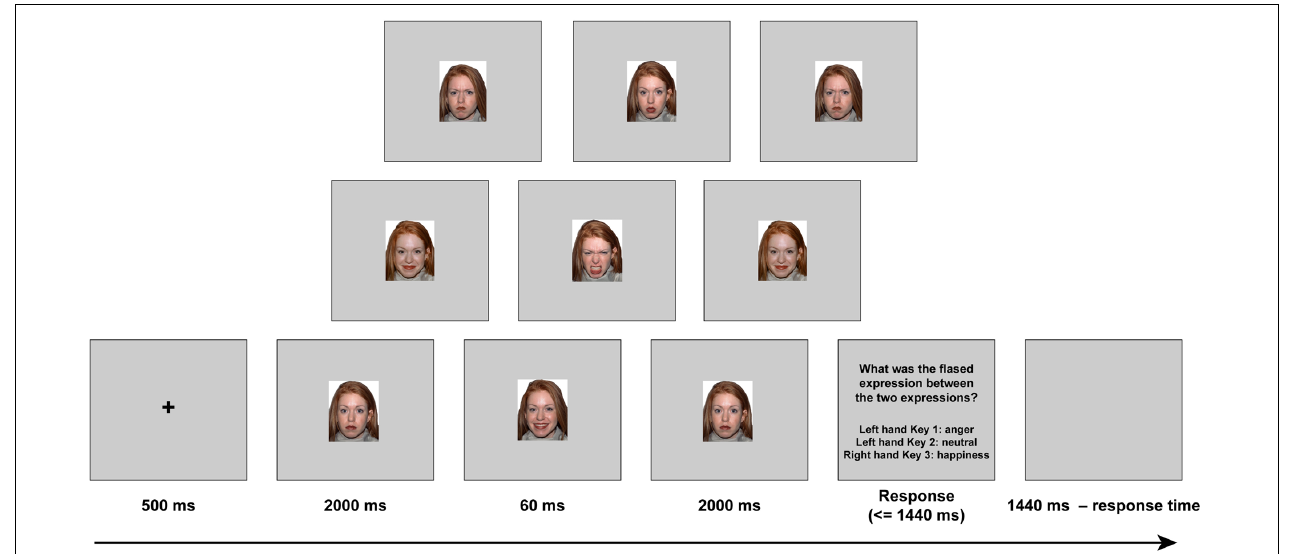
FIGURE 1 | The experimental setup of each trial.